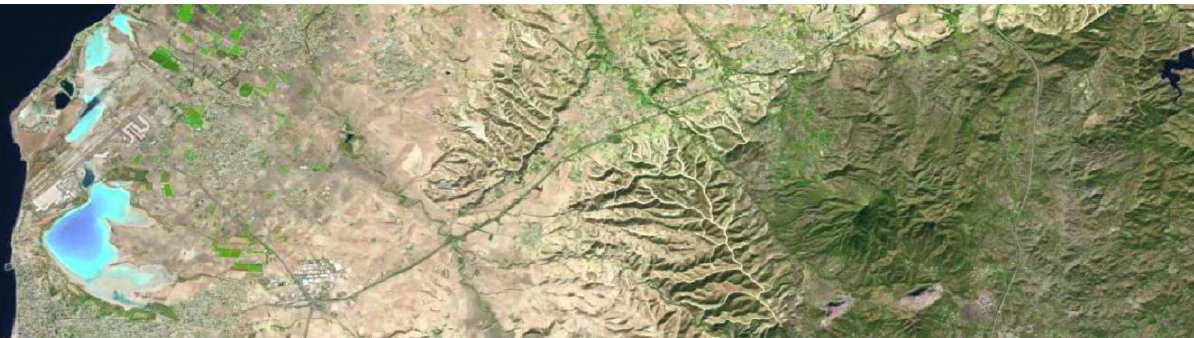
Figure 1. Fragment of one of the colected images in full resolution, oriented to the south to enhance natural hillshading (NASA_P)